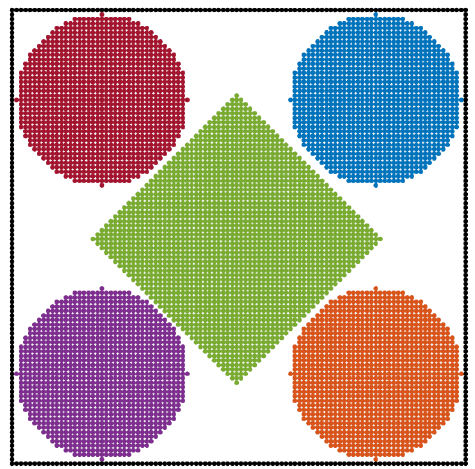
Figure 7. The optimal solution for the objects used in the first study involving rotational degrees of